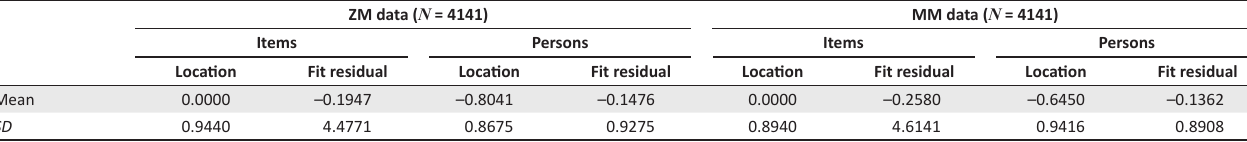
TABLE 6: Summary